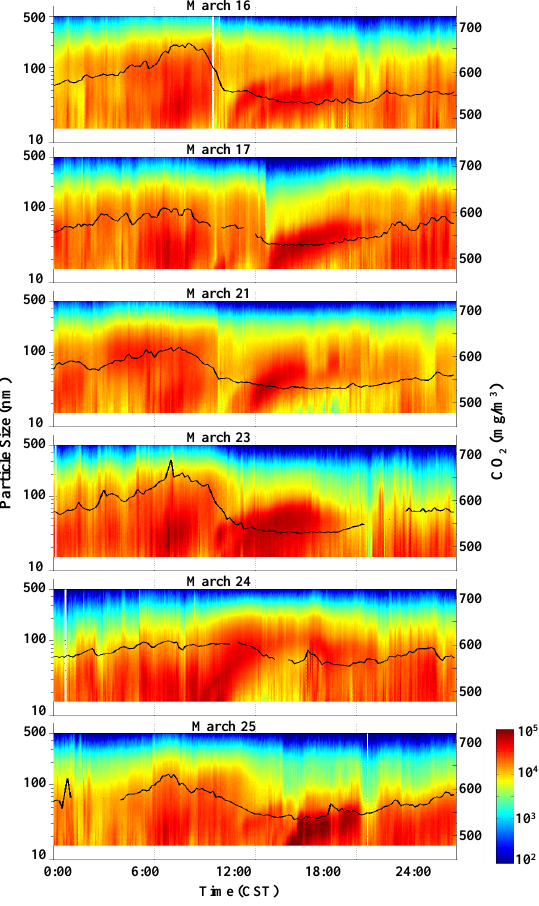
Figure 6. Colorplots of ultrafine growth events. Fig. 6. Colorplots of ultrafine growth events. Black lines show CO 2 concentrations.